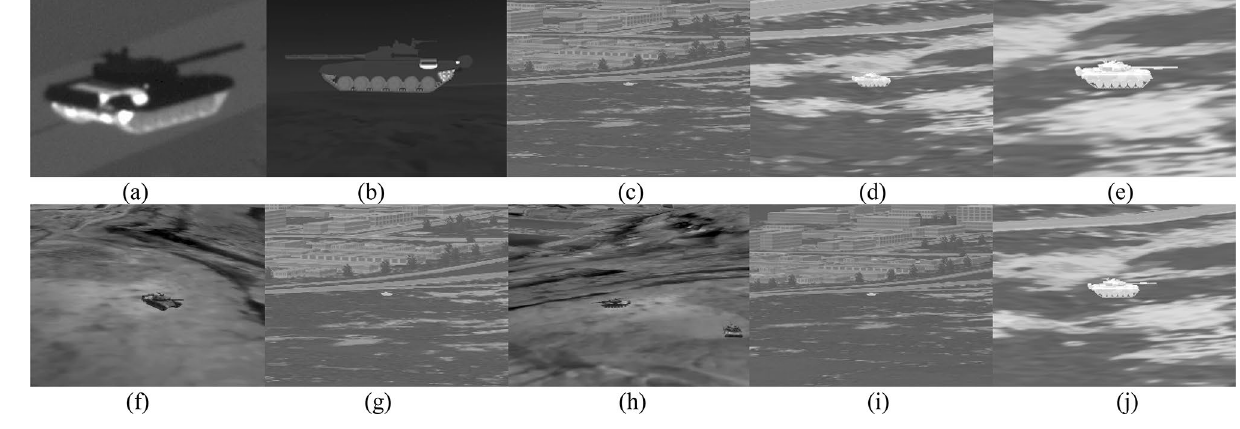
Figure 6. Infrared data set.